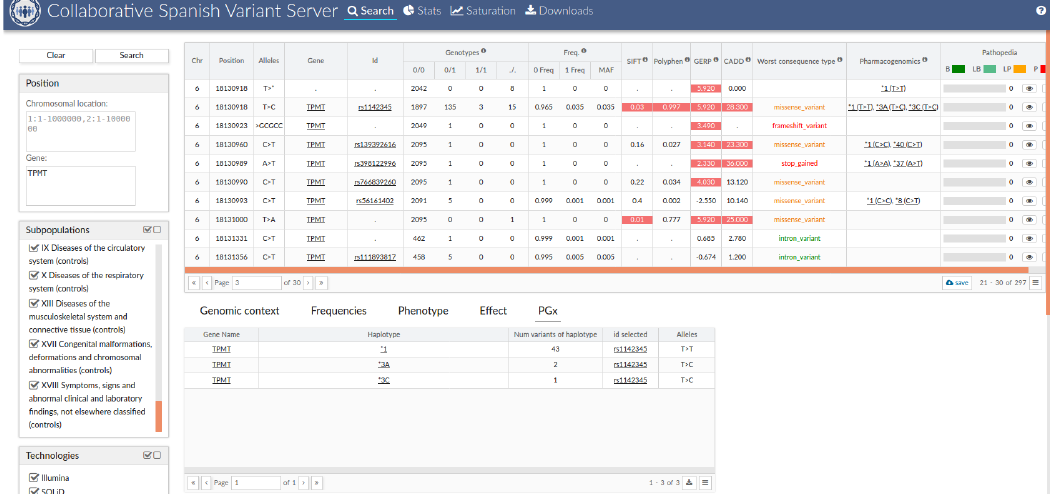
Figure 5. Screenshot of the Collaborative Spanish Variant Server (CSVS) v.5.0.0. showing an example of pharmacogenetic information of TPMT star (*) alleles or pharmacogenetic